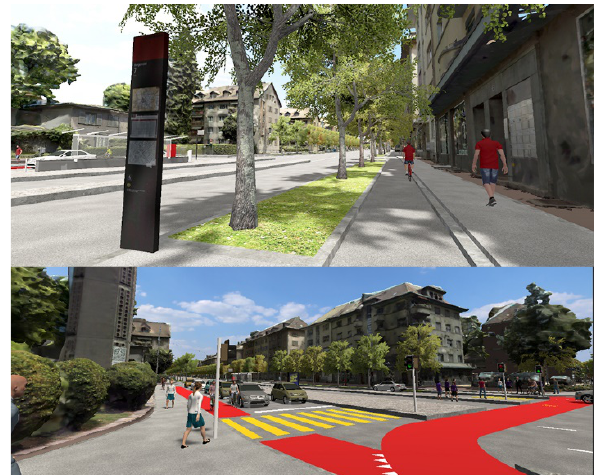
Figure 11. VR views of protected bicycle lane in different positions of different scenario models: Above: existing situation; Below: new design of the intersection.